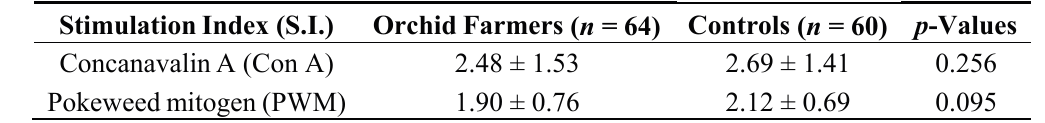
Table 6. The stimulation index (S.I.) of lymphoproliferative responses to mitogens in orchid farmers and in controls (Mean ±